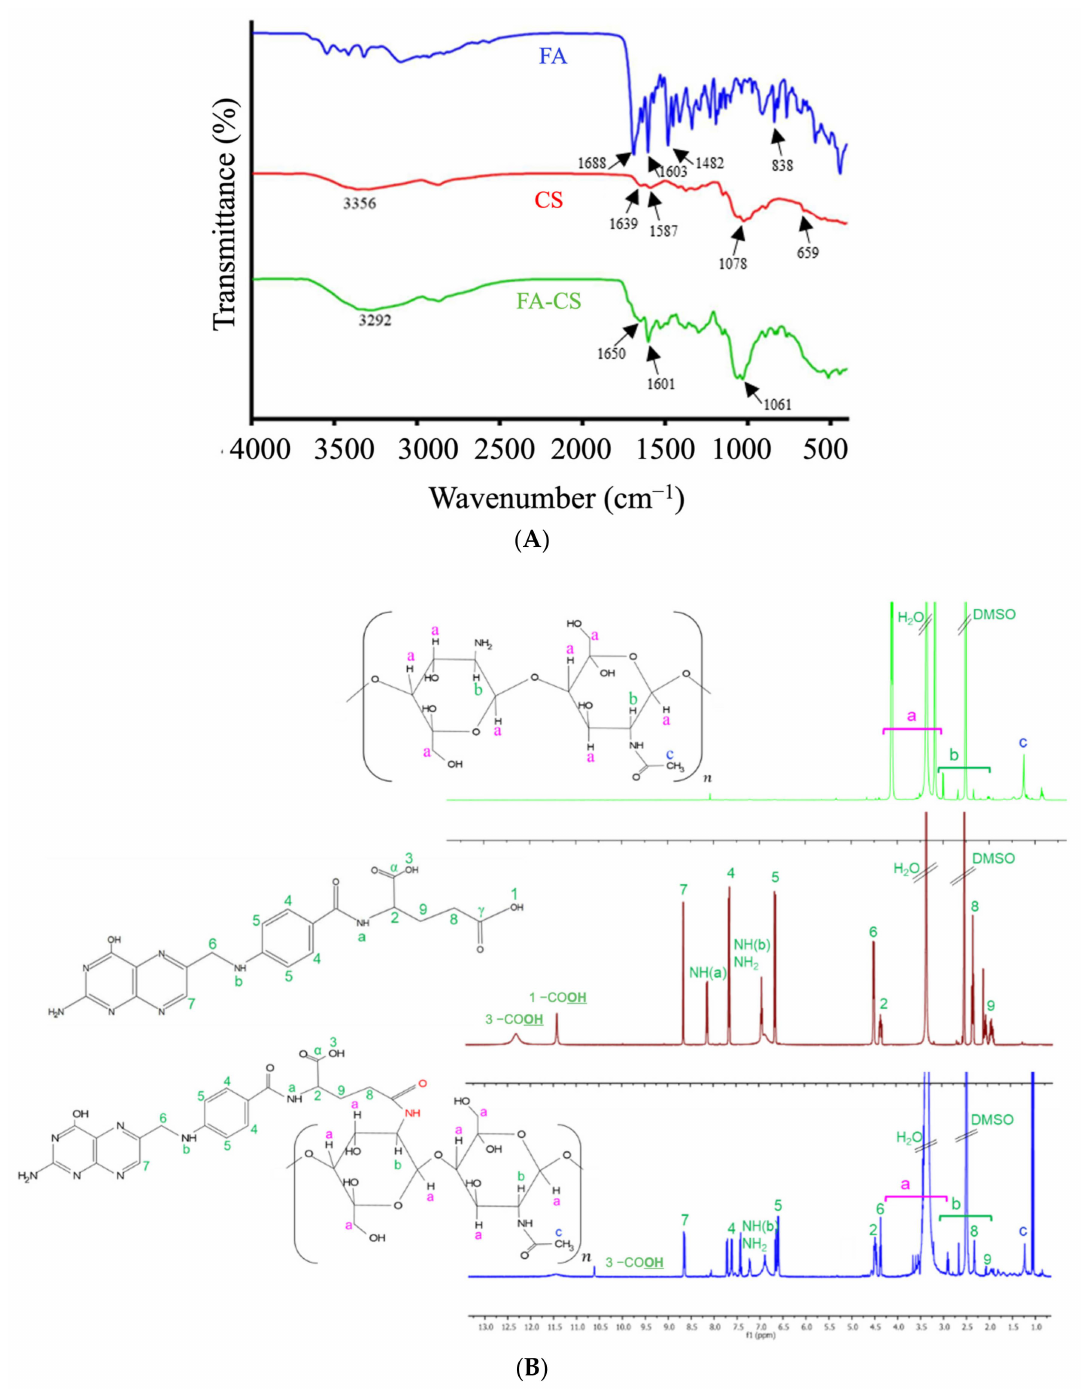
Figure 2. Characteristics of FA, CS, and FA-CS conjugates: ( A ) FT-IR spectra; ( B ) 1 H-NMR